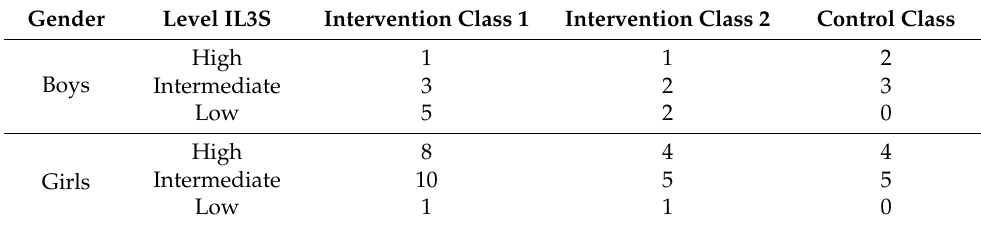
Table 1. Gender and baseline level of ideal L3 self (IL3S) in the three classes.